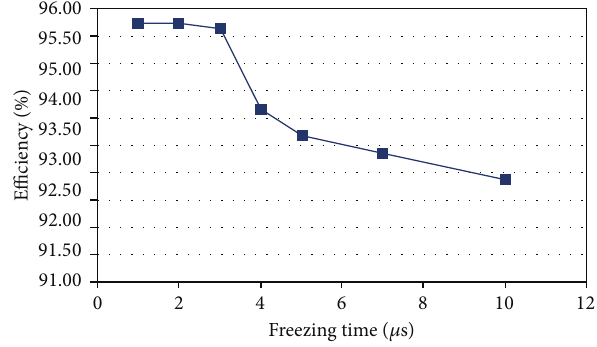
Figure 16: Efficiency versus sweeping time (clk@40 MHz, Hit- Rate@2.5 kHz/pixel).